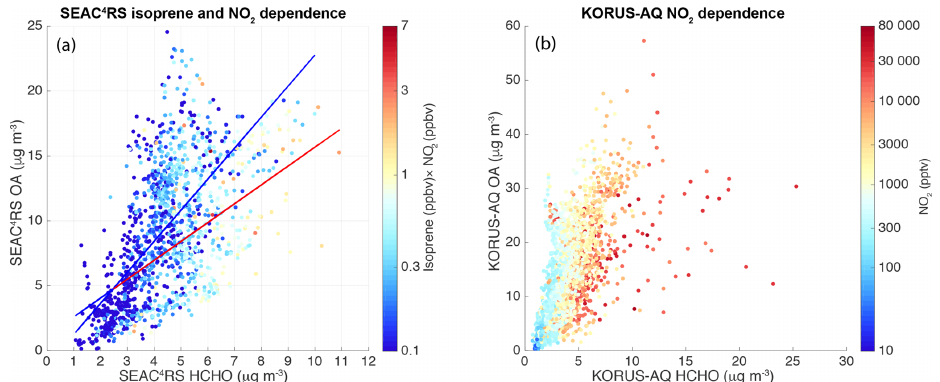
Figure 3. (a) A scatter plot of OA vs. HCHO for SEAC 4 RS non-BB low-altitude data color coded with the product of NO 2 and isoprene in log scale. The red and blue lines are the linear regression fits of high (>0.5) and low (<0.5) products of NO 2 (ppbv) and isoprene (ppbv), respectively. (b) A scatter plot of OA vs. HCHO for KORUS-AQ data color coded by log(NO 2 ).